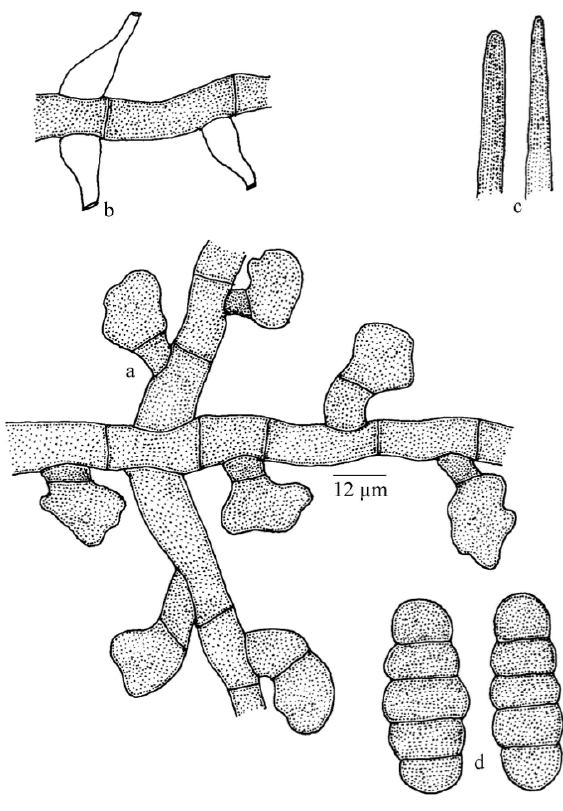
Figure 106. Meliola panici a - Appressorium; b - Phialide; c - Apical portion of mycelial setae; d - Ascospores